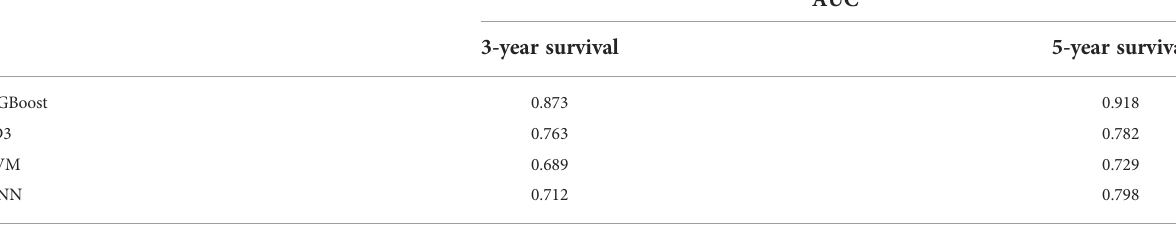
TABLE 3 Performance of prognostic models built by machine learning algorithms on test